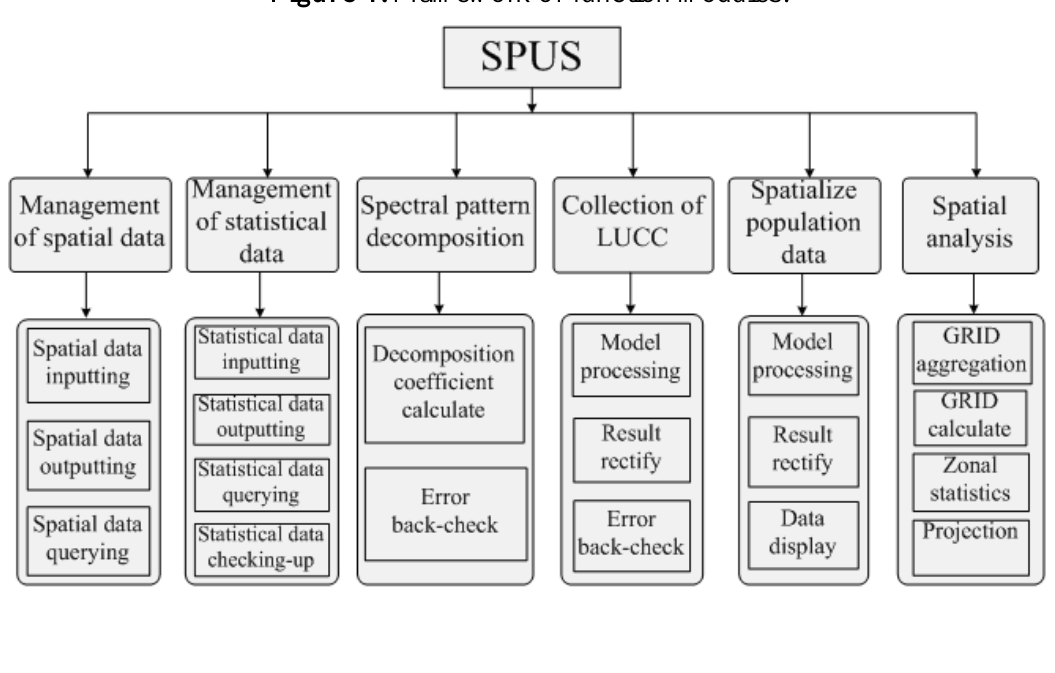
Figure 4. Framework of function